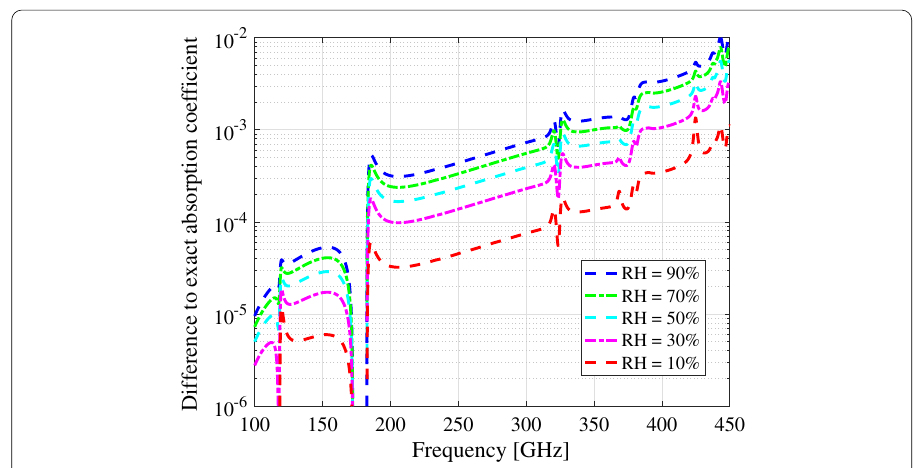
Fig. 1 An error of the proposed absorption coefficient. An error of the absorption coefficient of the proposed model to the exact one as a function of the frequency for different humidity levels before adding the fit polynomial g ( f ,